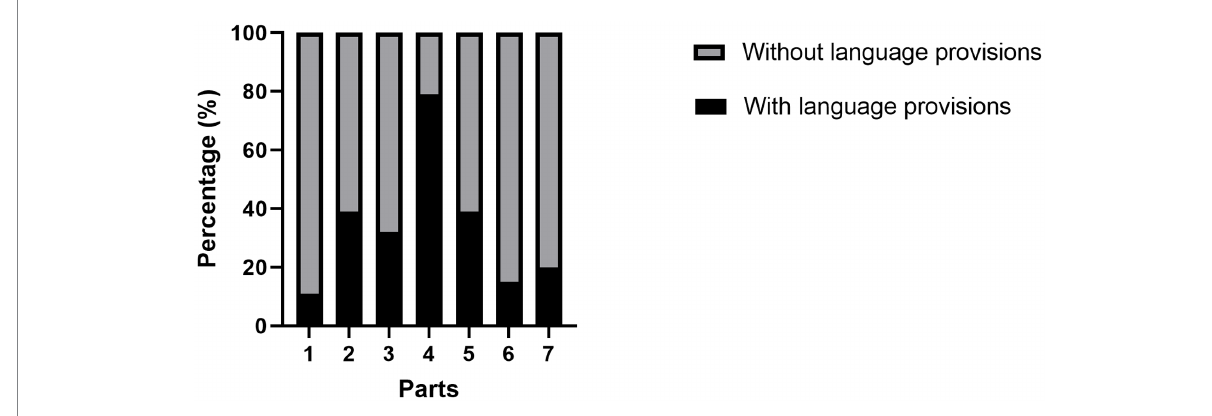
FIGURE 2 The relationship between constitutional parts and language provisions. “1” = PR; “2” = GP; “3” = TS; “4” = RD; “5” = SA; “6” = NO; “7” = SU.